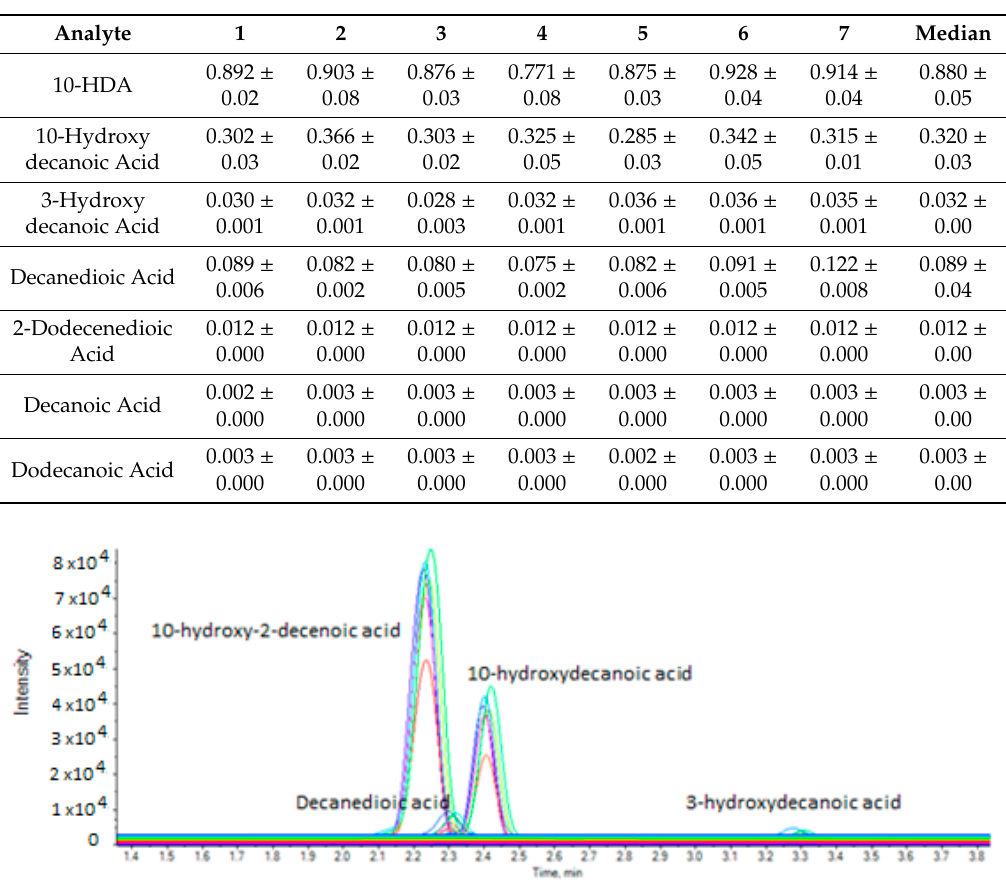
Table 3. Contents of free fatty acids in real samples (g / 100 g fresh RJ).